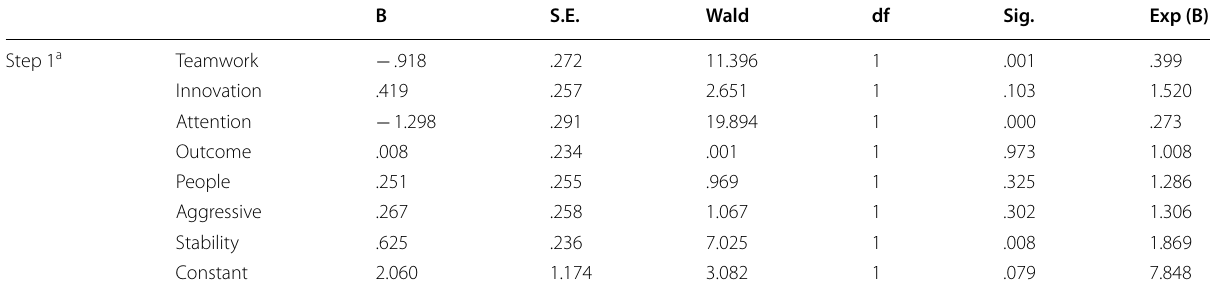
Table 6 Overall variables in the equation B S.E.